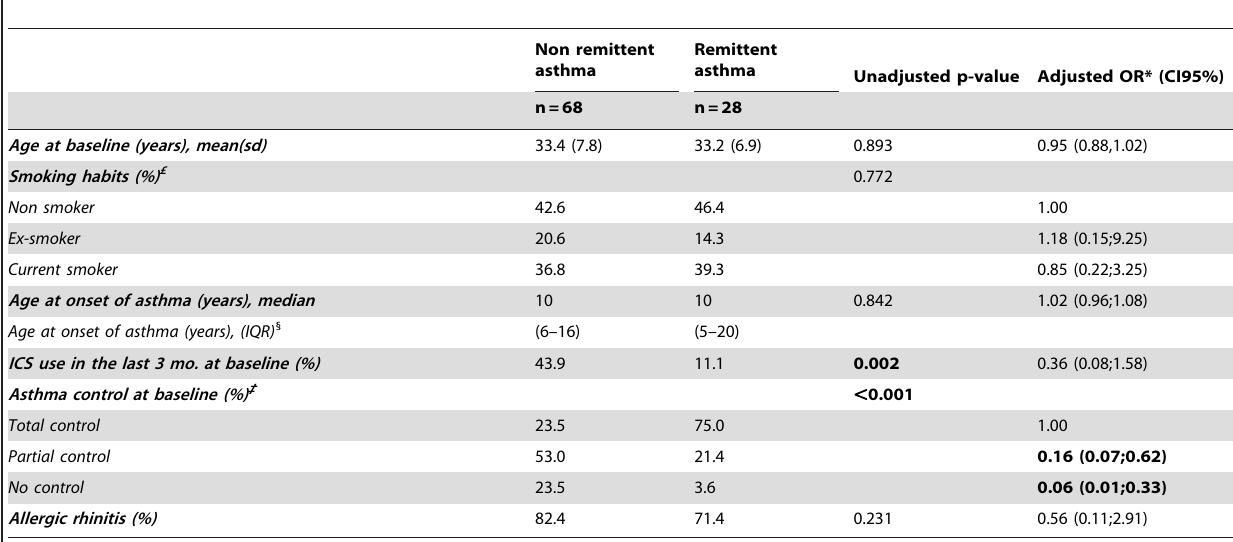
Table 2. Main baseline characteristics of the men with non remittent asthma and with remittent asthma at follow-up and adjusted Odds Ratios* (CI95%) for the effects of these variables reported at baseline on asthma remission at follow-up.